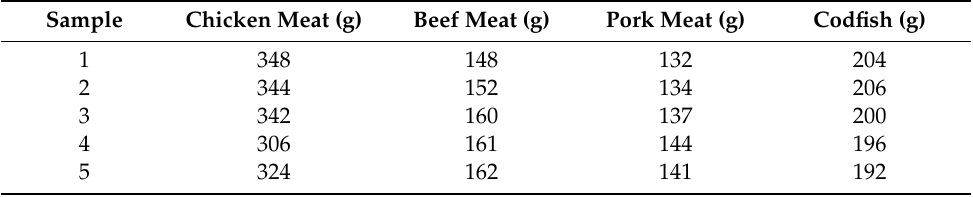
Table 2. Mass of samples of different foods, employed as the training set for PCA model development.